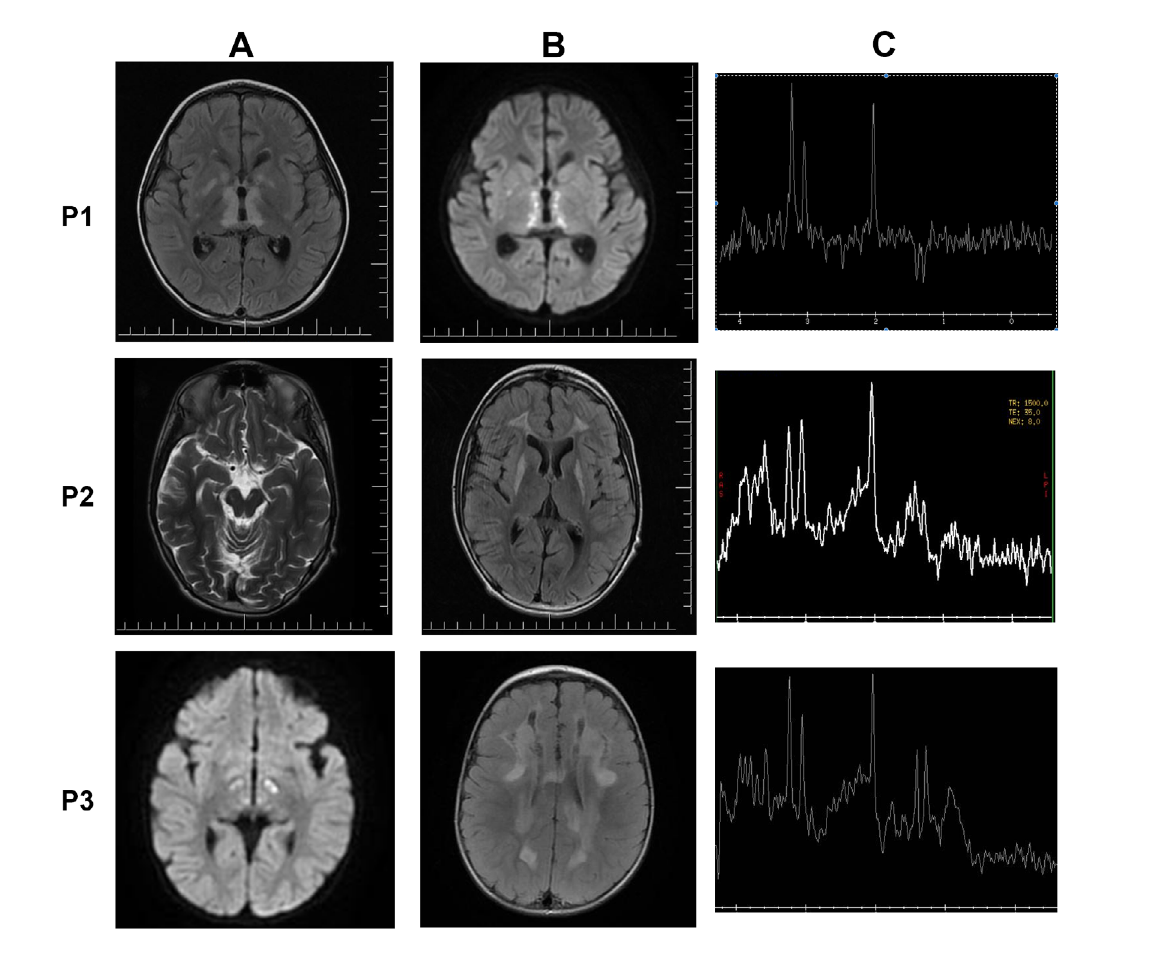
Figure 1 ‒ Clinical features of the patients. (A and B) MRI of patients P1, P2 and P3 showing white matter changes and symmetric lesions in different regions of the brain, red arrow indicated altered brain region. (C) Elevated lactate in each patient measured by MR spectroscopy, indicated by red arrow.